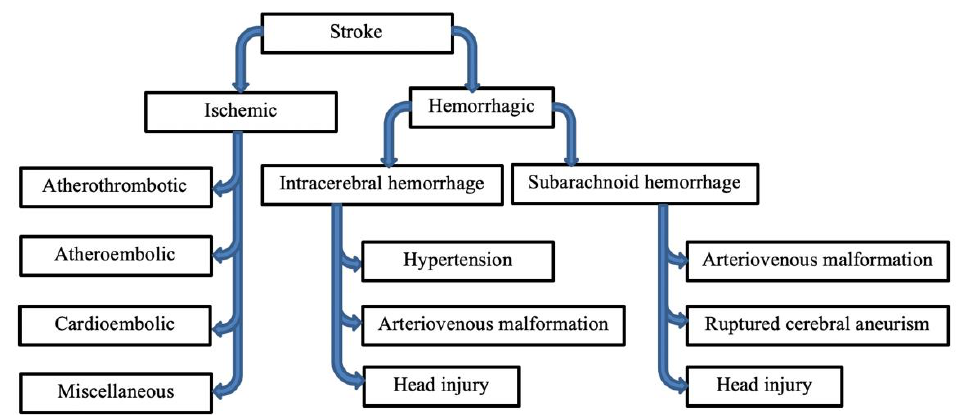
Figure 1. Classifications of stroke. Strokes are classified as either ischemic or hemorrhagic, which are further subcategorized.